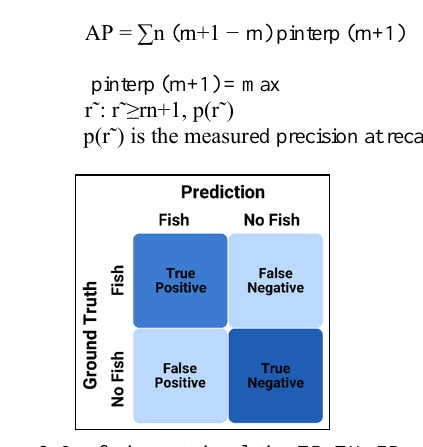
Figure 6 . Confusion matrix relating TP, TN, FP and